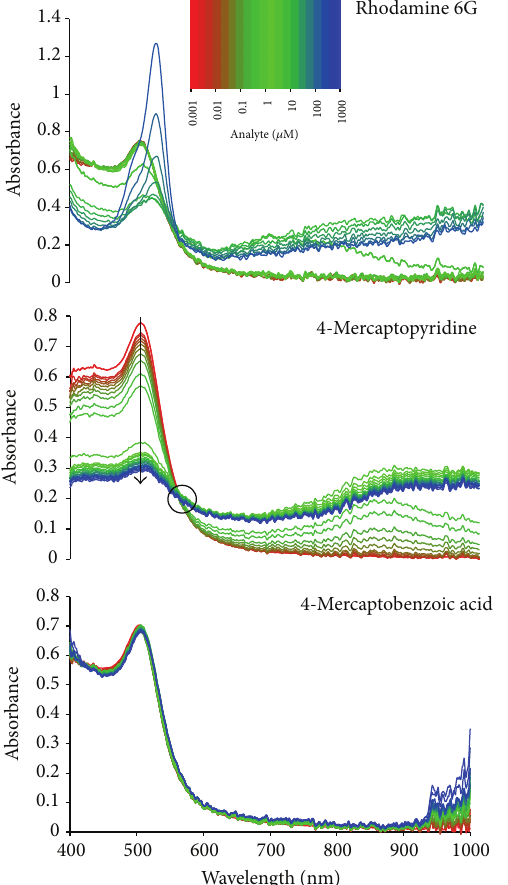
Figure 4: Extinction spectra of Au@Ag nanoparticle solutions as a functionofaddedtitrants(SERSlabels):R6G,top;MPY,middle;and MBA, bottom. Titrant concentrations are color-coded as above and spectra were acquired concurrently with the Raman